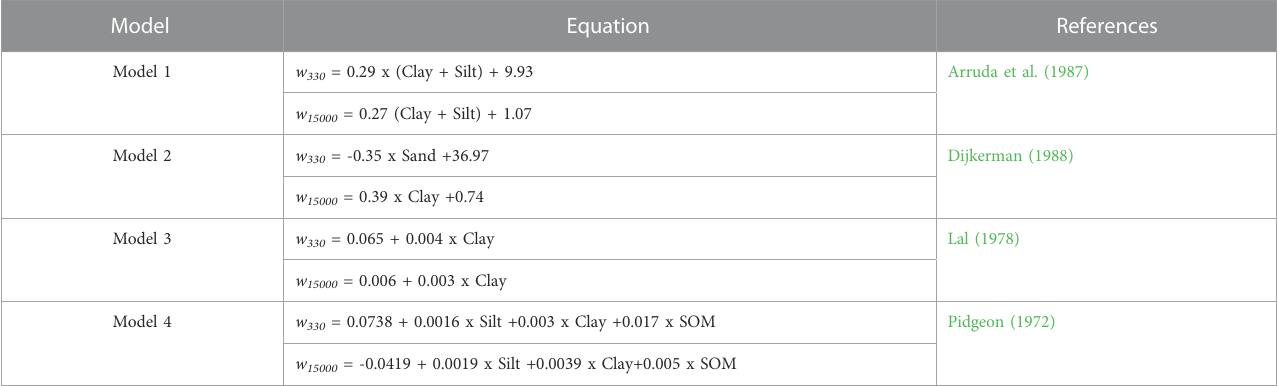
TABLE 1 Selected PTFs from literature to predict soil moisture at fi eld capacity (w 330 ) and permanent wilting point (w 15000 ) using water expressed in gravimetric moisture (g.g − 1 ). Model